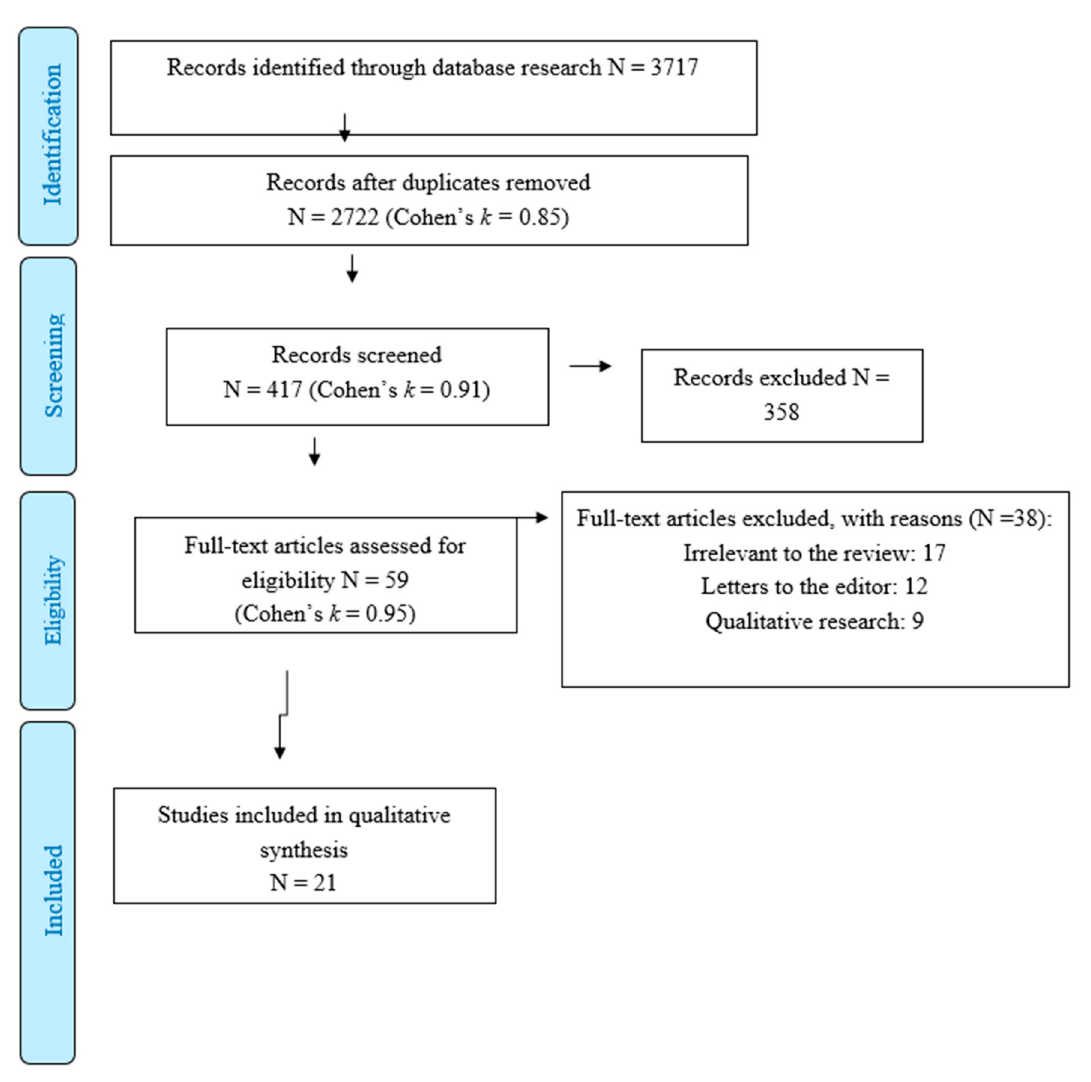
Figure 1. PRISMA flow diagram of literature search and selection of